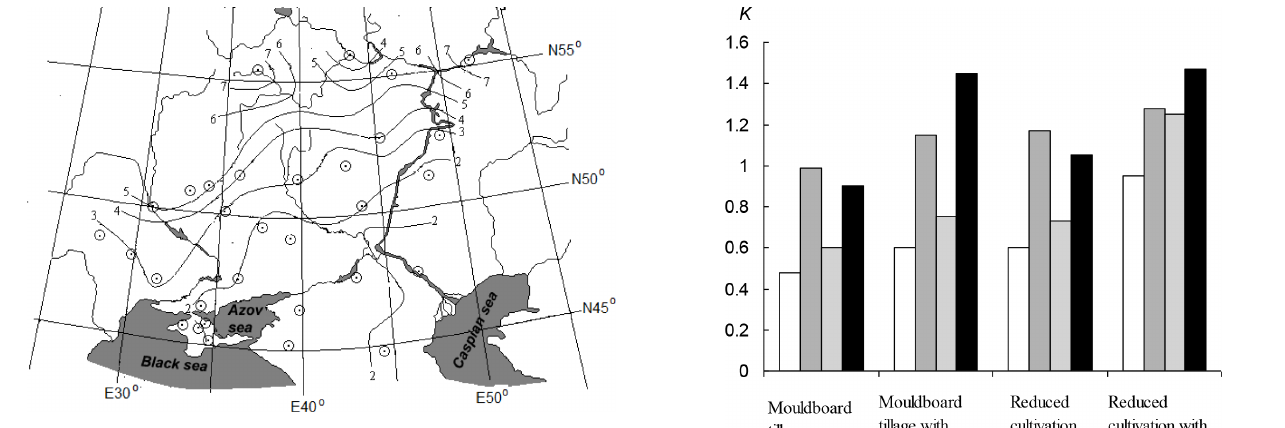
Figure 4. The increase in many-year averages of winter wheat pro- ductivity (in centnerha − 1 ) due to mulching the soil with plant re- mains. Figure 5. Energetic efficiency of various tillage modes with tak-